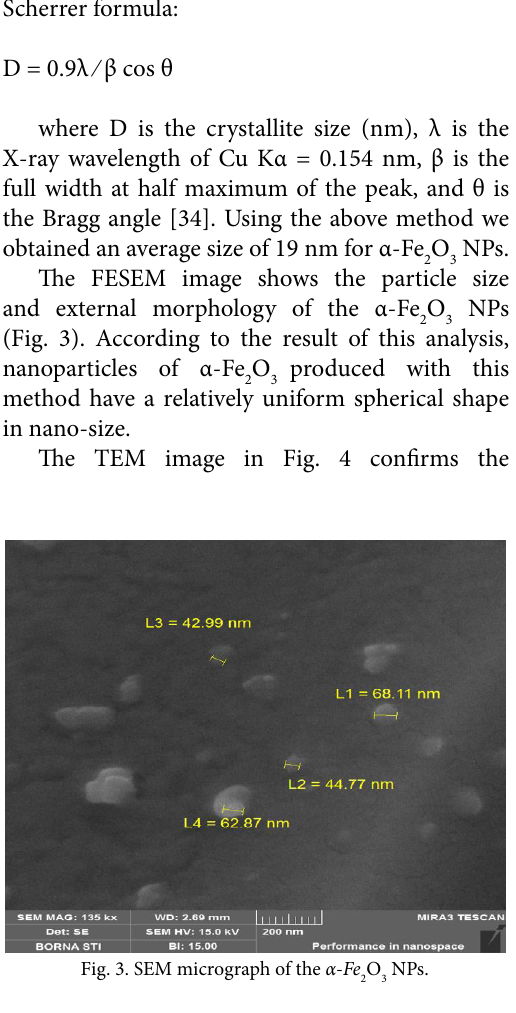
Fig. 3. SEM micrograph of the α -Fe 2 O 3 NPs.